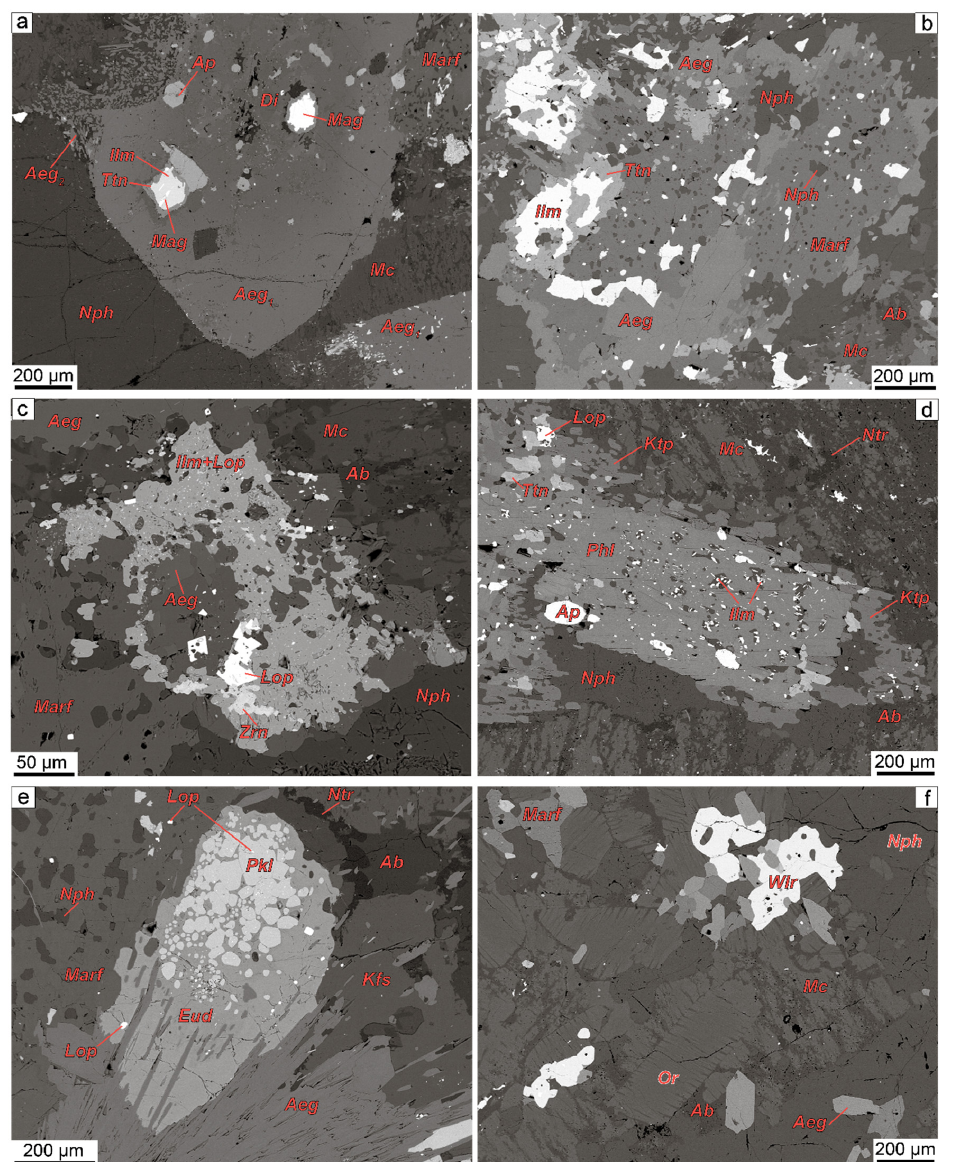
Figure 5. BSE images showing the textural relations and mineral paragenesis in uneven-grained nepheline syenite: ( a ) symplectite intergrowths of nepheline and magnesio-arfvedsonite are surrounded by aegirine rims, and ilmenite is replaced by titanite (Sample LV-156-118); ( b ) inclusions of loparite-(Ce) and zircon in ilmenite (Sample LV-157-83); ( c ) phlogopite contains inclusions of ilmenite, fluorapatite, and titanite and is surrounded by a ferri-katophorite rim (Sample LV-157-83); ( d ) relict diopside surrounded by rims of aegirines of different composition (Aeg 1 = Quad 0 Jd 7 Aeg 93 ; Aeg 2 = Quad 0 Jd 5 Aeg 95 ; Sample LV-156-77); ( е ) parakeldyshite grains with inclusions of loparite-(Ce), surrounded by an EGM rim (Sample LV-156-108); ( f ) recrystallization of feldspar. Microcline is intensively resorbed by nepheline, and orthoclase laths are crystallized (Sample LV-372). In uneven-grained nepheline syenite, nepheline is replaced by vishnevite (Figure 4a), and feldspar is recrystallized with the formation of small crystals of orthoclase